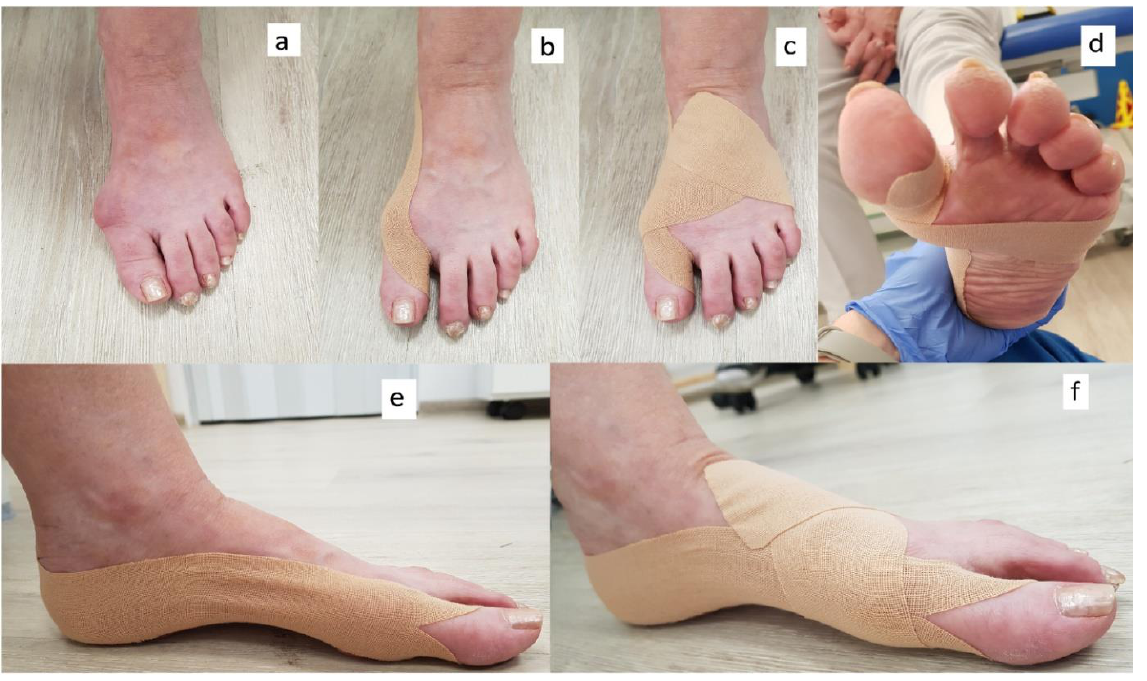
Figure 2. Application of the kinesiology taping. Foot before application: view of the dorsal surface ( a ), foot after the application of the first Y-shaped tape: dorsal ( b ) and medial ( e ) side, foot after the application of the second I-shaped patch: dorsal ( c ), plantar ( d ) and medial ( f ) side of the foot.